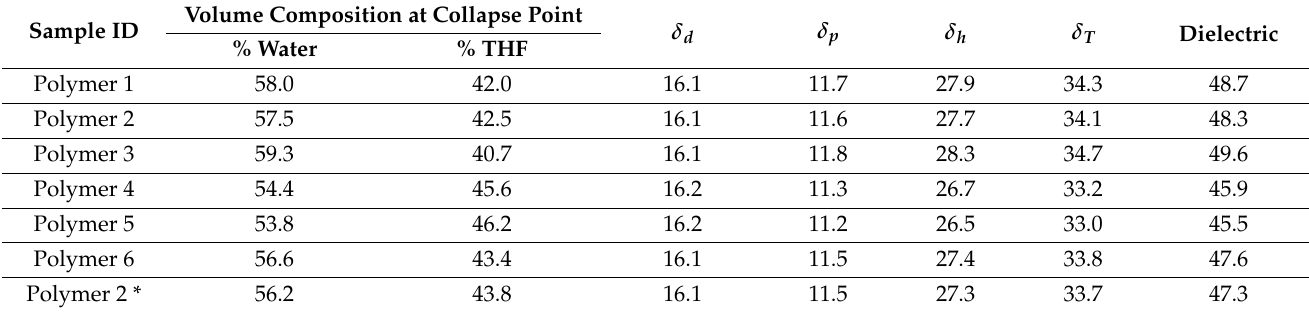
Table 4. Collapse composition for polymers 1-6 and Hansen parameters of solvent composition at collapse.